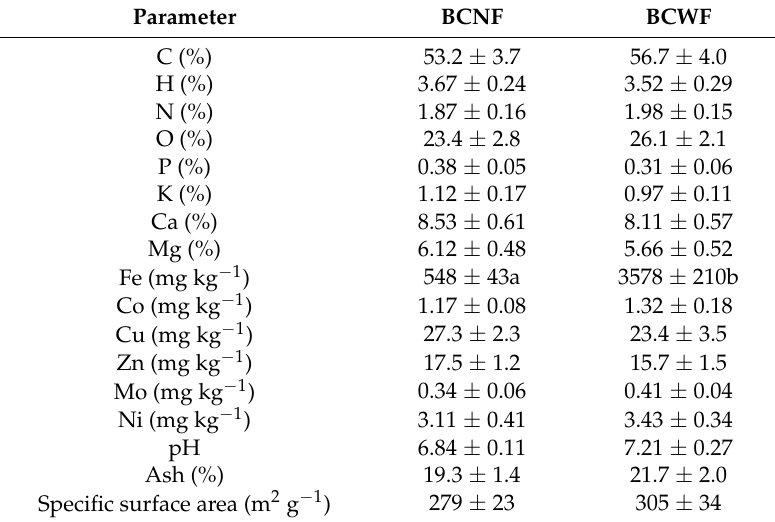
Figure 1. SEM images of biochars prepared using peanut stalks from the plot without Fe addition ( A ) and from the plot with Fe addition ( B ). Table 2. Physicochemical properties of BCNF and BCWF. Mean (± SE, n = 5).